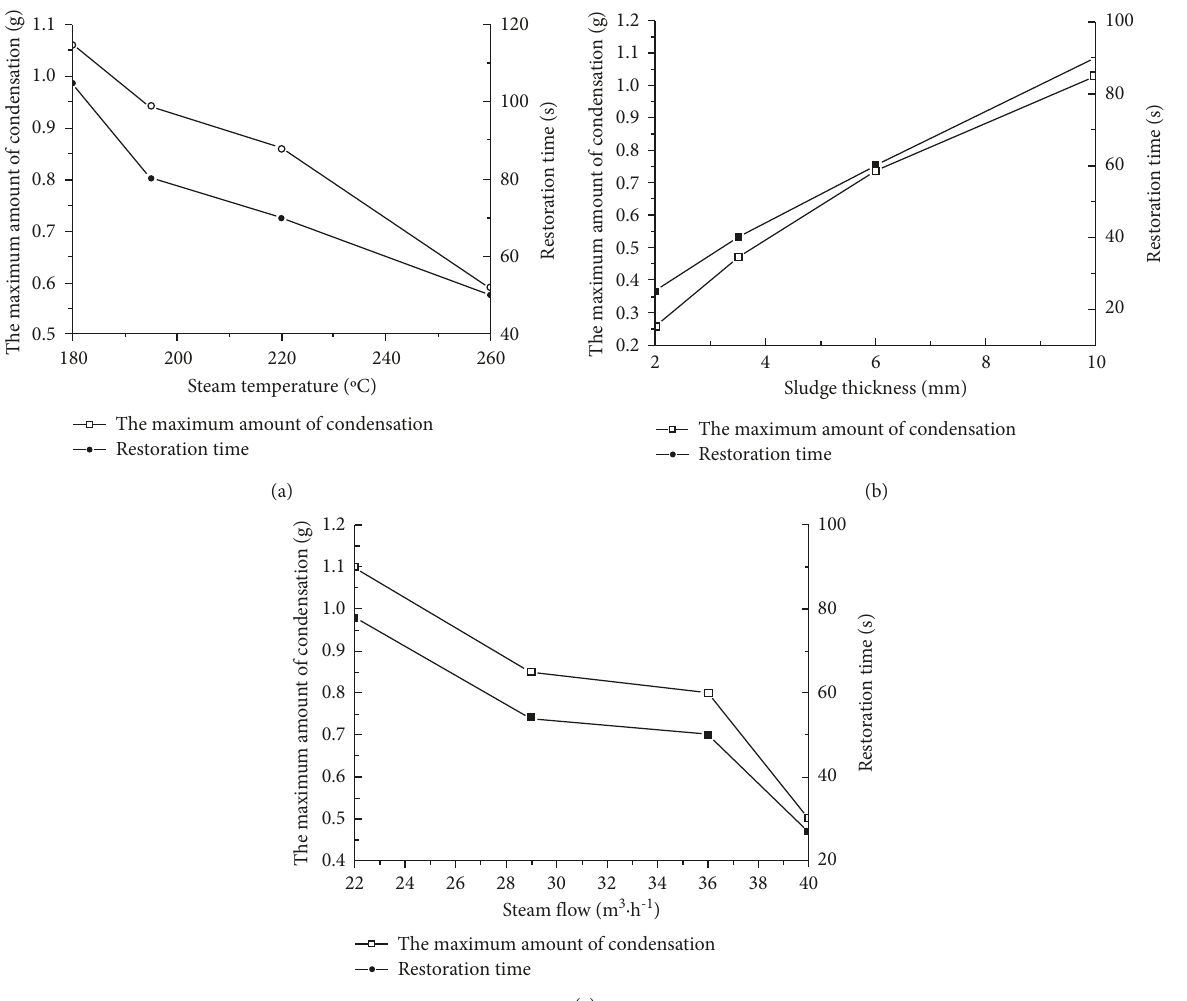
Figure 5: Relationship between the amount of maximum condensation and restoration times and different drying conditions. (a) Re- lationship between the amount of maximum condensation and restoration times and steam temperature. Note: sludge thickness was 6mm, and steam flow was 22m 3 /h. (b) Relationship between the amount of maximum condensation and restoration times and sludge thickness. Note: steam temperature was 220 ° C, and steam flow was 22 m 3 /h. (c) Relationship between the amount of maximum condensation and restoration times and steam flow. Note: steam temperature was 220 ° C, and sludge thickness was